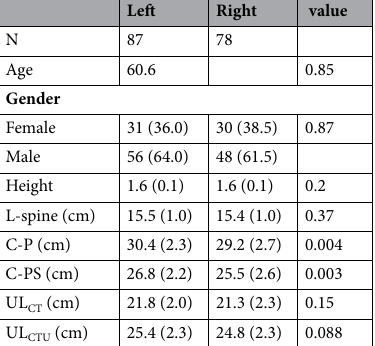
Table 1. Patient characteristics and demographic data. Age is presented as number only. Other values are presented as mean with (standard deviation or percentage in gender). ULCTU, ureteral length measured with curved multiplanar reformation (MPR) technique, by tracing ureter from ureteral pelvic junction (UPJ) to ureteral vesical junction (UVJ).